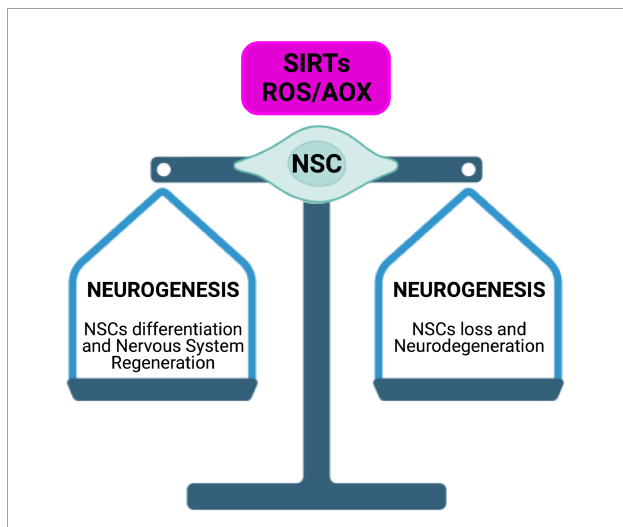
FIGURE9 Energy metabolism regulation in NSCs fate determination. Imbalance of redox cellular homeostasis, can affect SIRTs expression levels and activity, leading to a modulation of the balance between stem cell quiescence, self-renewal, and differentiation.